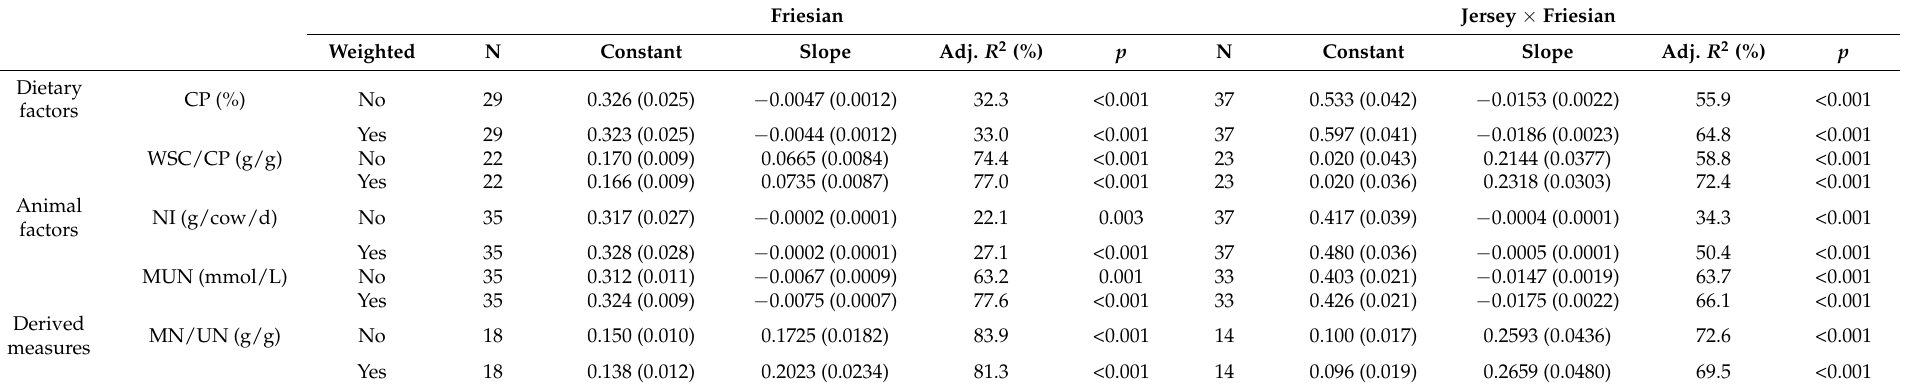
Table 4. Linear regression equations (coefficients (SE)) for the relationships between NUE and selected parameters for ryegrass-fed Friesian and Jersey × Friesian dairy cows. N = number of group means used in each analysis. Models are given for both unweighted and weighted group